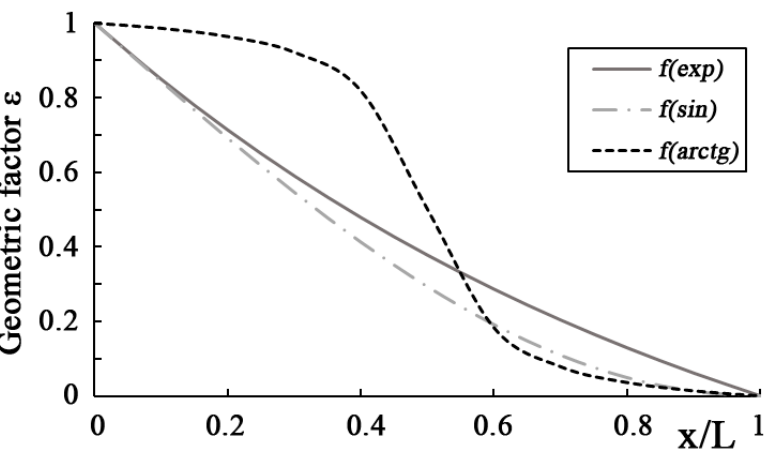
Figure 4. Distribution curves of the geometric factor ε .